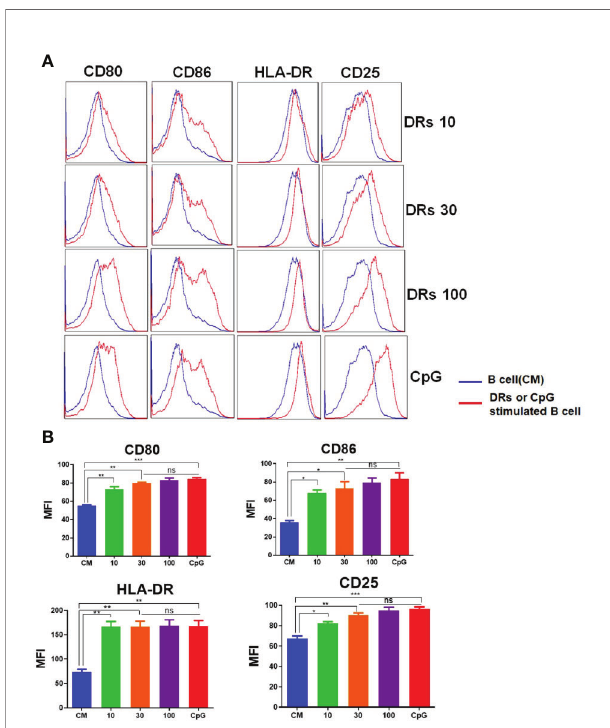
FIGURE 2 | DRibbles-induced activation of human B cells. Puri fi ed human B cells were stimulated with various concentrations of HepG2.2.15 DRibbles (0, 10, 30, or 100 m g/ml) or CpG (10 m M). After 72 h incubation, single cell suspensions were collected and measured the expression of costimulatory molecules CD80, CD86, the human major histocompatibility complex (MHC) molecule HLA-DR, and the activation marker CD25 on human B cells by fl ow cytometric analysis. (A) Representative cyto fl ourograph from one of the donors. (B) Cumulative data from three independent experiments from three different healthy donors. CM indicated complete medium. MFI indicated mean fl uorescent intensity. ns, P > 0.05, * p < 0.05, ** p < 0.01, *** p <